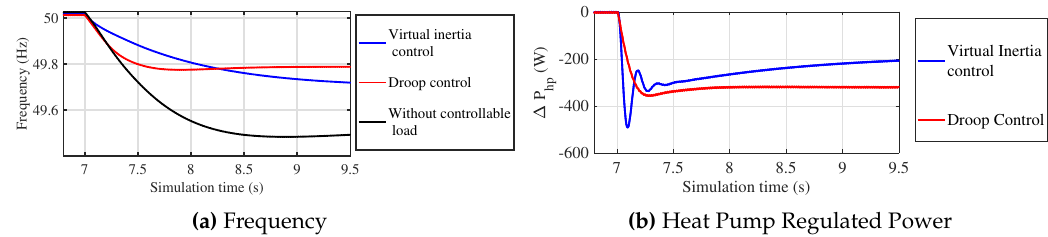
Figure 12. Response of the distribution system for droop or virtual inertia controlled VSHP.